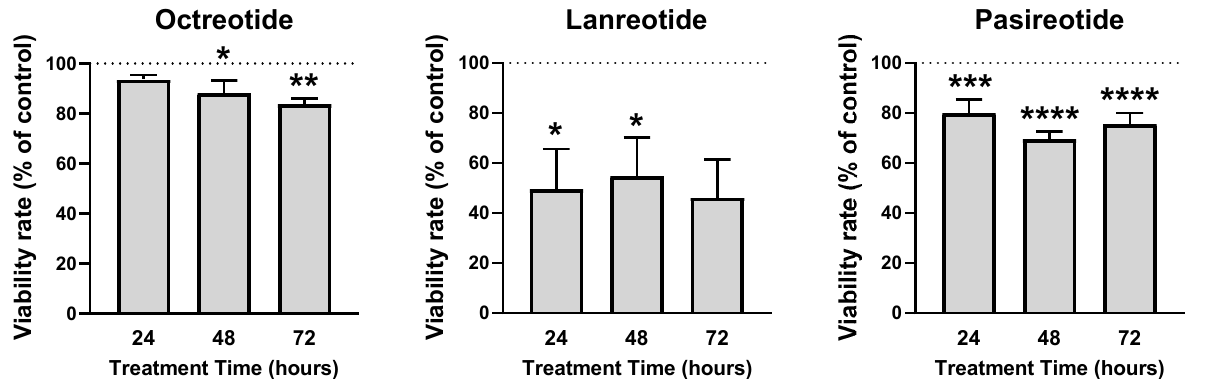
Figure 2. Effect of different somatostatin analogues (octreotide, lanreotide, and pasireotide) on cell proliferation OSS primary cell cultures. Proliferation rate (24- to 72-h treatment) was measured by Alamar Blue reduction. Data are expressed as percent of vehicle-treated control (set at 100%). Values represent the mean ± SEM ( n = 3–4 tumors, 3–4 replicates/treatment). Asterisk represents statistically significant differences (*, p < 0.05; **, p < 0.01; ***, p < 0.001; ****, p < 0.0001).